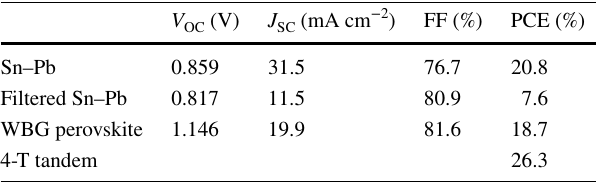
Table 2 Photovoltaic parameters of various types of solar